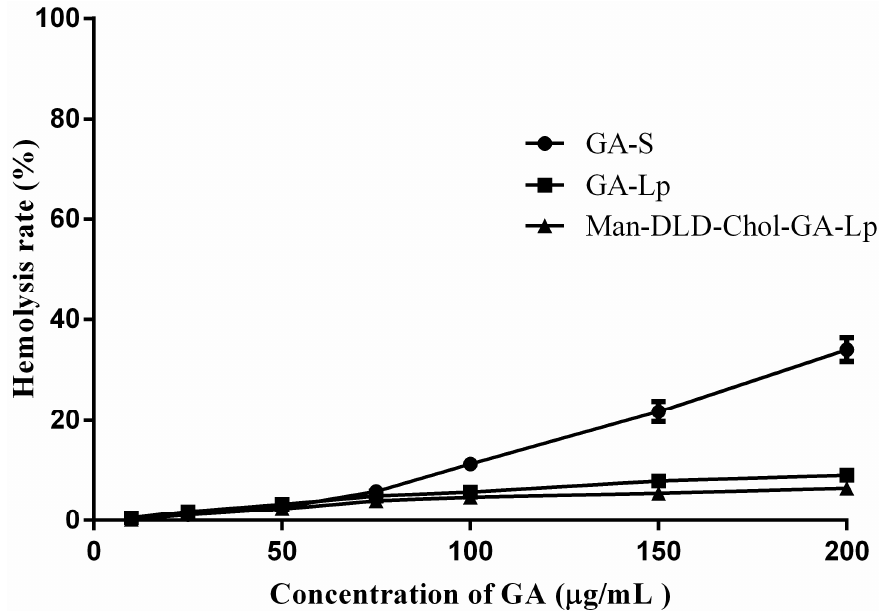
Figure 3. Hemolysis rates of GA solution (GA-S), GA-Lp and